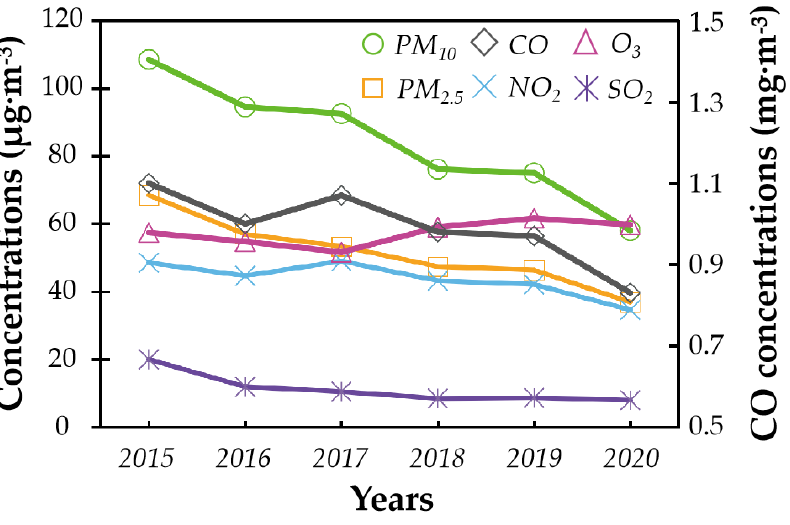
Figure 3. Interannual variations of near-surface concentrations of PM 10 , PM 2.5 , NO 2 , O 3 , and SO 2 in the left Y -axis and the CO concentrations in the right Y -axis observed in Wuhan during 2015–2020. Based on the daily PM 2.5 concentration ranges over 0–75 µ g · m − 3 , 75–115 µ g · m − 3 , 115–150 µ g · m − 3 , and higher than 150 µ g · m − 3 , ambient environment was classified respectively